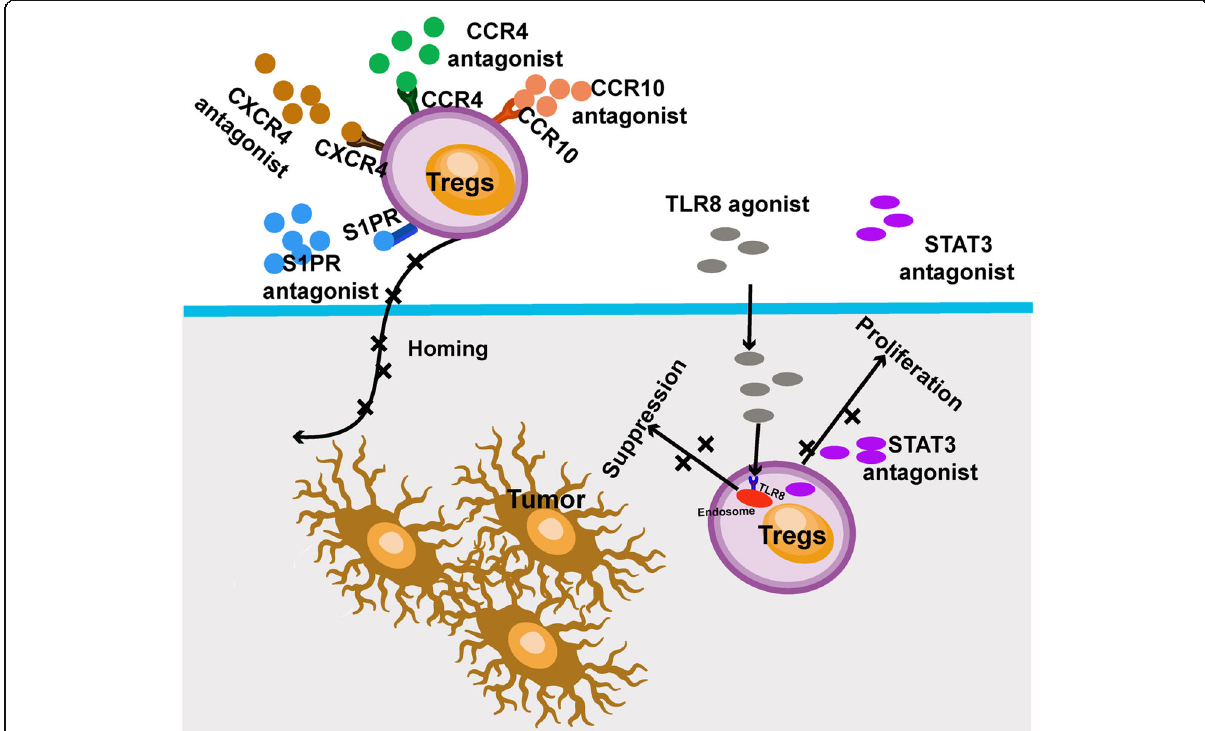
Fig. 3 Chemokine and small molecule inhibitors targeting Tregs in melanoma. Anti-CCR4 antibody, CXCR4 antagonist, CCR10 antagonist, and S1PRs antagonist may inhibit recruitment of Tregs to the TME. Other small molecule inhibitors such as STAT3 inhibitors and TLR8 agonists inhibit proliferation of Tregs and enhance TCR